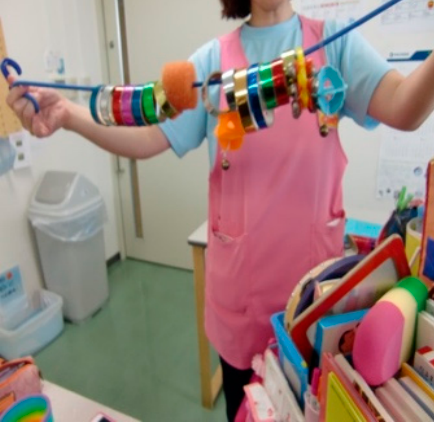
Figure 3. World of the sea (created using a plastic sheet).